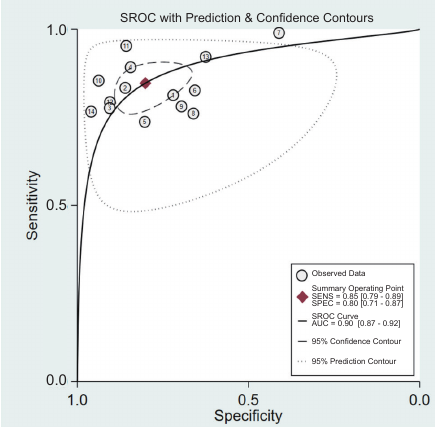
Figure 4 The SROC curve for assessment of SMI to distinguish breast masses. SENS: sensitivity, SPEC: specificity, AUC: area under the cure, SROC: summary receiver operating